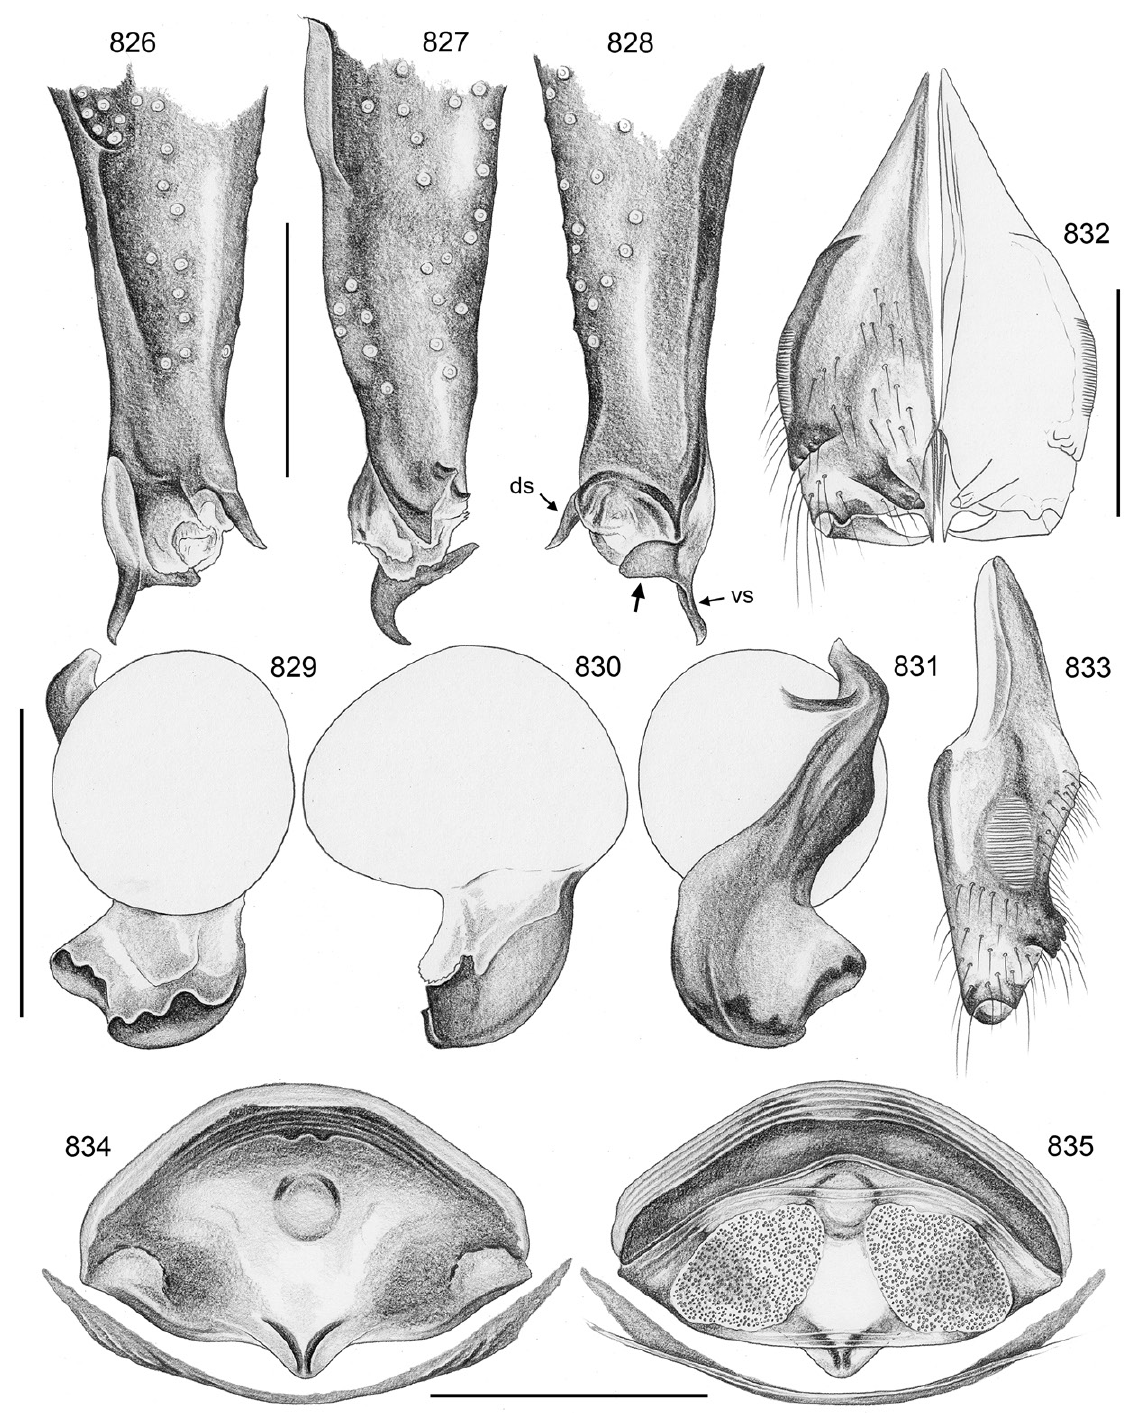
Figs 826–835. Crossopriza maculipes (Spassky, 1934); male and female from Turkmenistan, 5 km SW of Bazar-Tepe (SZMN). 826–828 . Left procursus, prolateral, dorsal, and retrolateral views; arrow: retrolateral branch of ventral sclerite. 829–831 . Left genital bulb, prolateral, dorsal, and retrolateral views. 832–833 . Male chelicerae, frontal and lateral views. 834–835 . Cleared female genitalia, ventral and dorsal views. Abbreviations: ds = dorsal sclerite; vs = ventral sclerite. Scale bars: 826–828 = 0.3 mm; 829–835 = 0.5